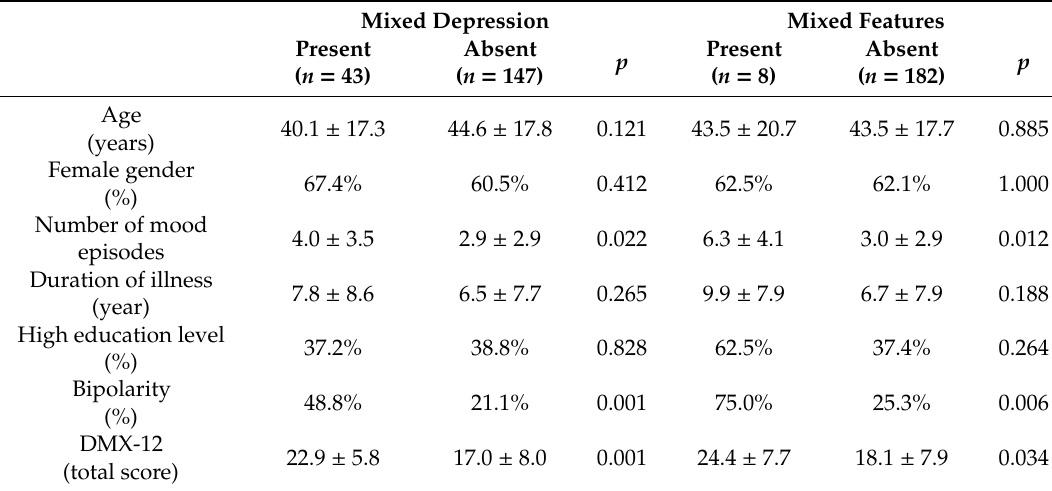
Table 1. Comparisons of clinical backgrounds between non-mixed patients and those with mixed depression or mixed